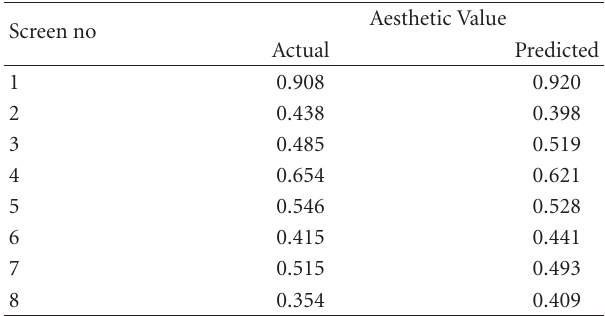
Table 4: Actual and predicted aesthetic values of the eight screens. Screen